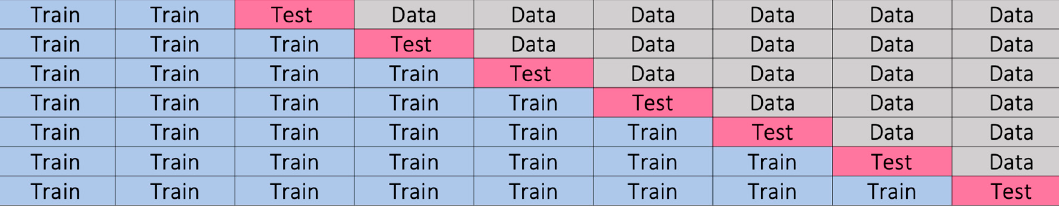
Figure 3. Rolling origin cross-validation process.